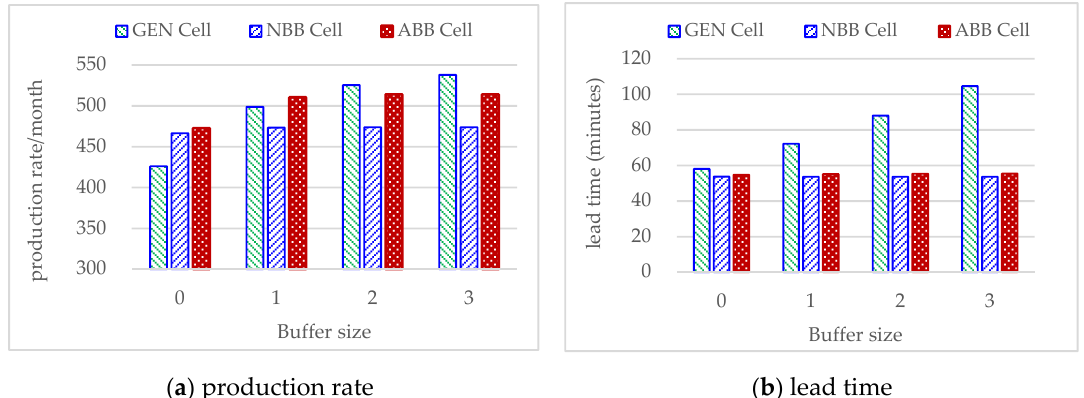
Figure 9. Performance of different assembly systems over varying buffer sizes in terms of ( a ) production rate and ( b ) production lead time.